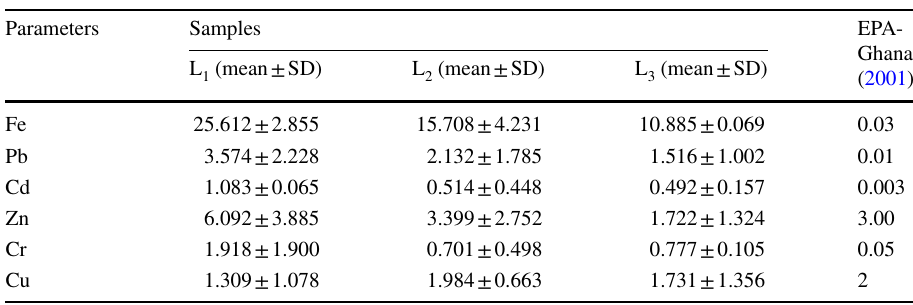
All results are in mg/L